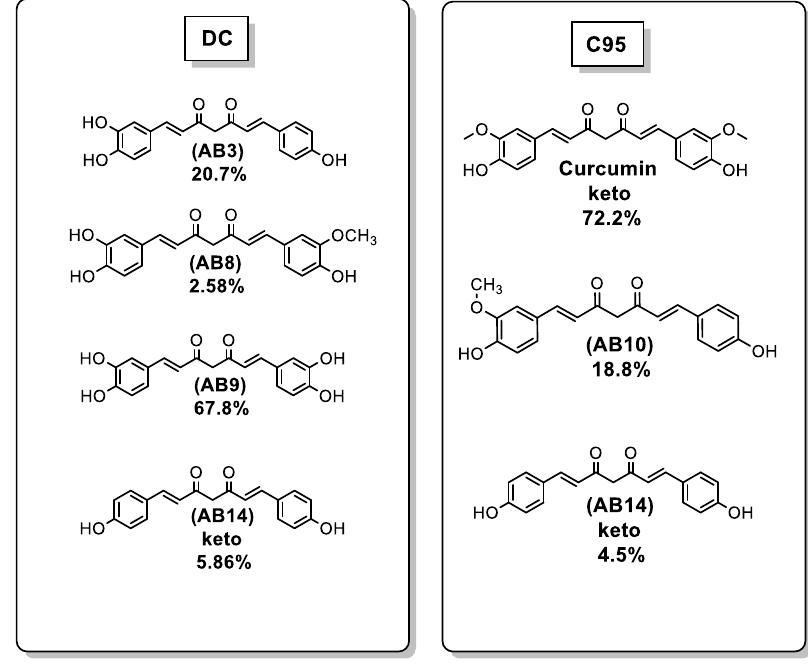
Figure 6. curcuminoids having antioxidant properties. Figure 6. Mixed curcuminoids having antioxidant